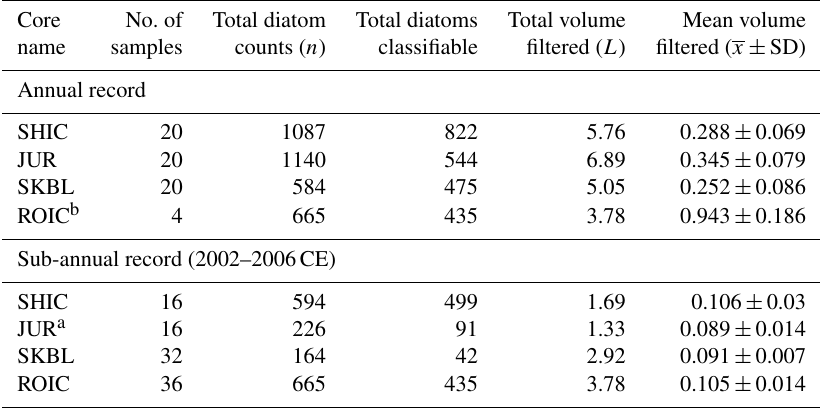
Table 2. Main features and basic statistics of the annual and sub-annual diatom records for each ice core. Core No. of